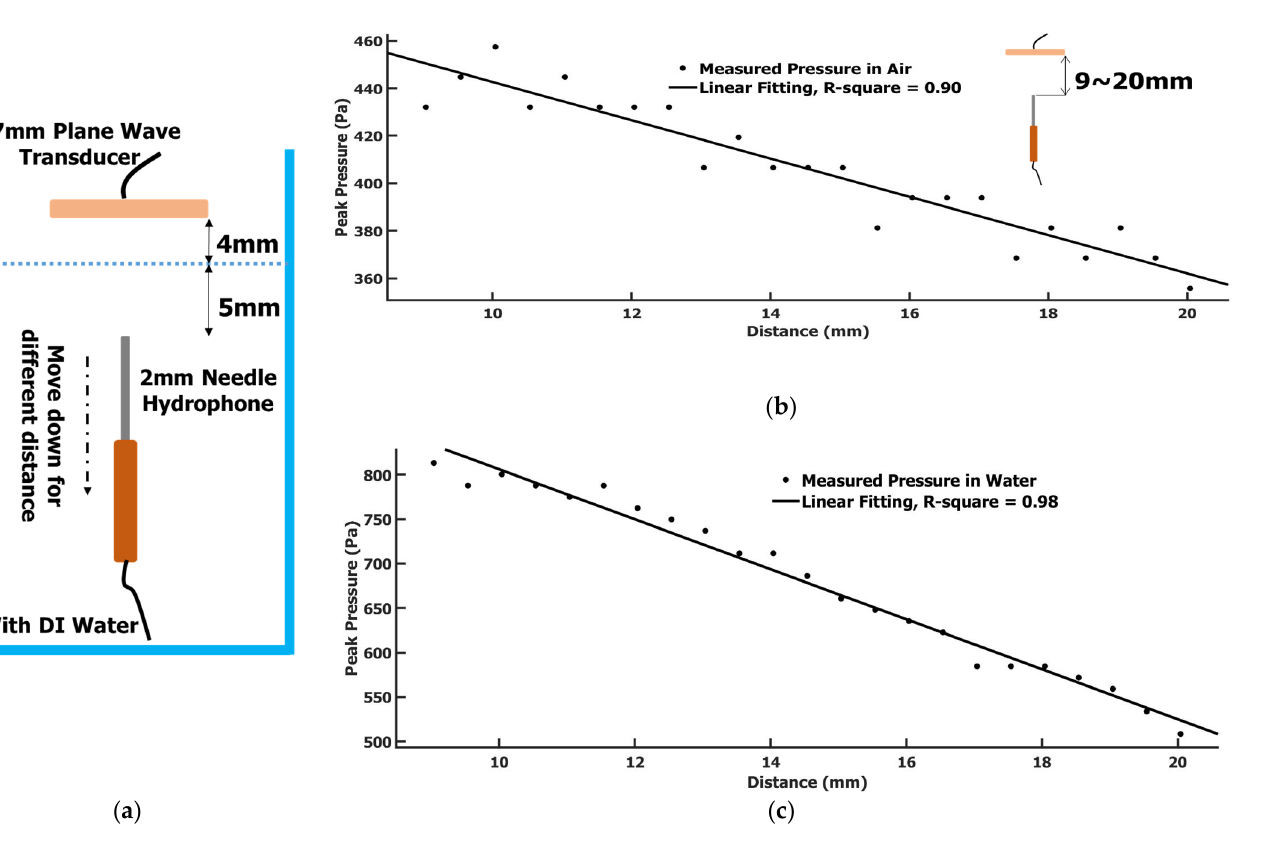
Figure 2. ( a ) The calibration setup; ( b ) The needle hydrophone in air measured pressure at different distance and its linear fitting (transmitter: Airmar air-coupled transducer, in air); ( c ) The needle hydrophone in water measured pressure at different distance and its linear fitting (transmitter: Airmar air-coupled transducer, in air).